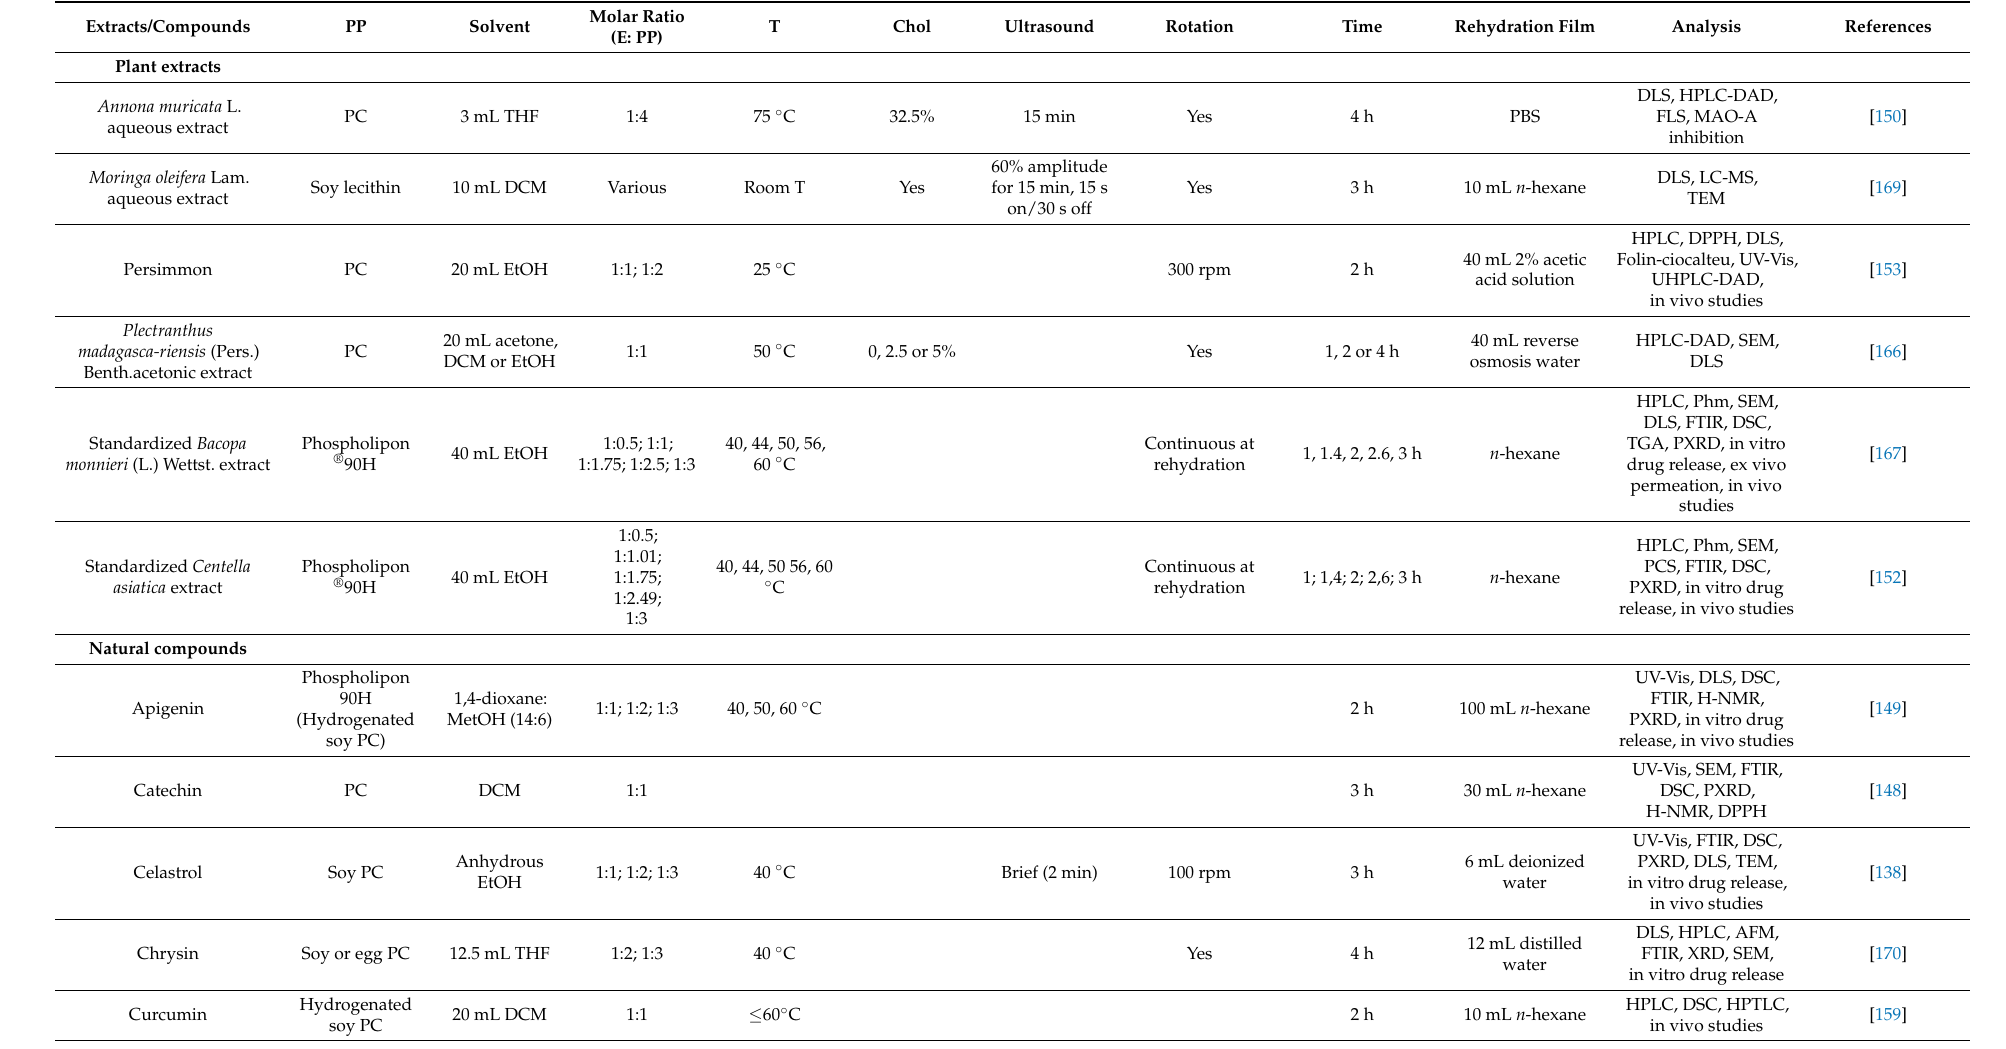
Table 3. Nanophytosomes intended to encapsulate neuroprotective compounds and